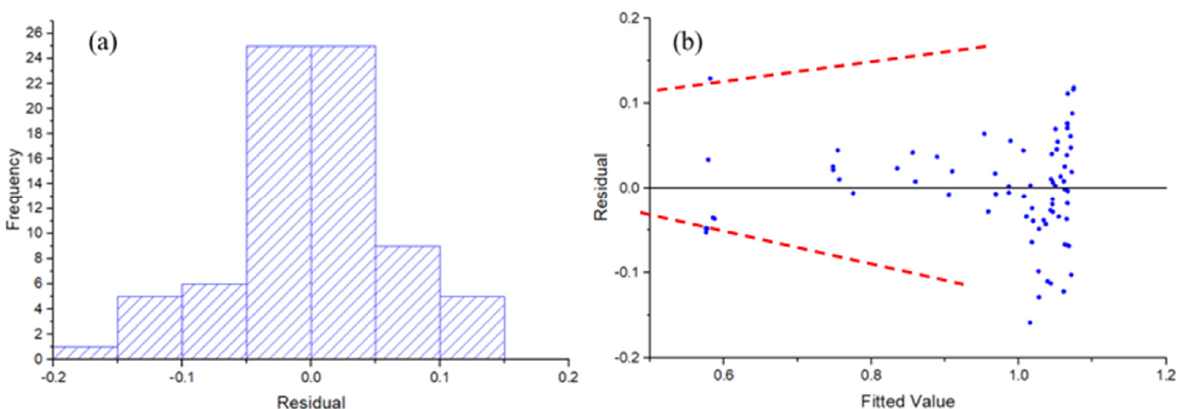
Figure 7. Residual plots of the single parameter model ( a ) residual histogram plot, ( b ) normal residual of the fitted curve (calculated value subtracted by measured value).